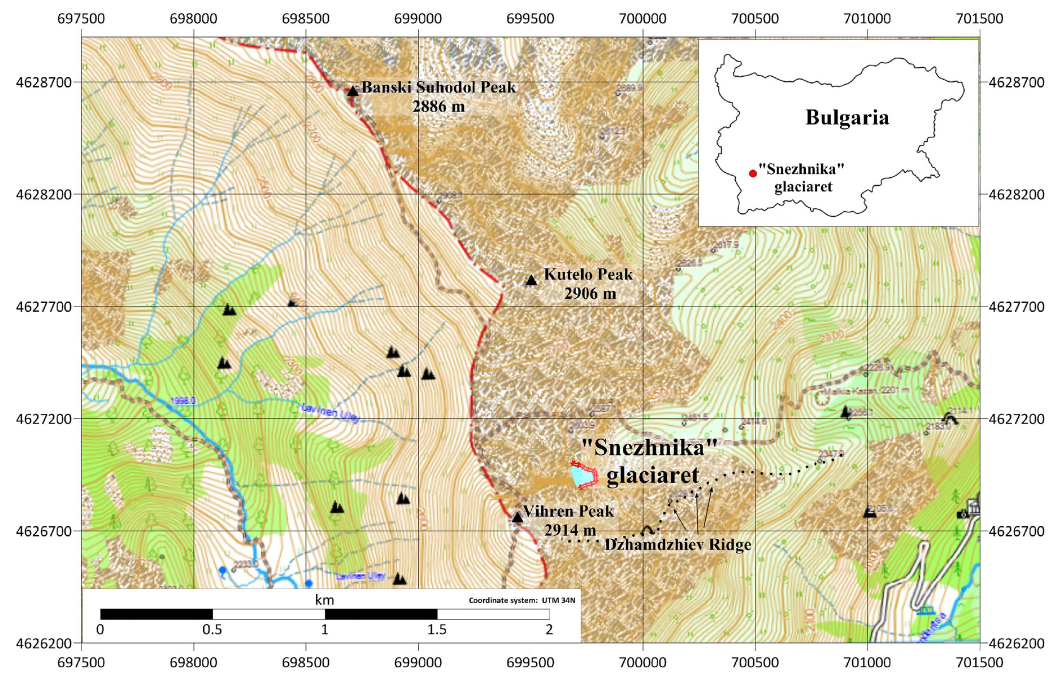
Figure 1. Snezhnika microglacier in the Golyam Kazan cirque, surrounded by the highest peaks in the Pirin Mountains – Vihren and Kutelo. On the northern side of the cirque is the Dzhamdzhiev ridge, which starts from the Vihren peak and ends in the valley near the Banderitsa hut. The map base layer is provided by http://karta.bg (last access: 1 December 2022, map version OFRM Geotrade 2022Q1 TOPO